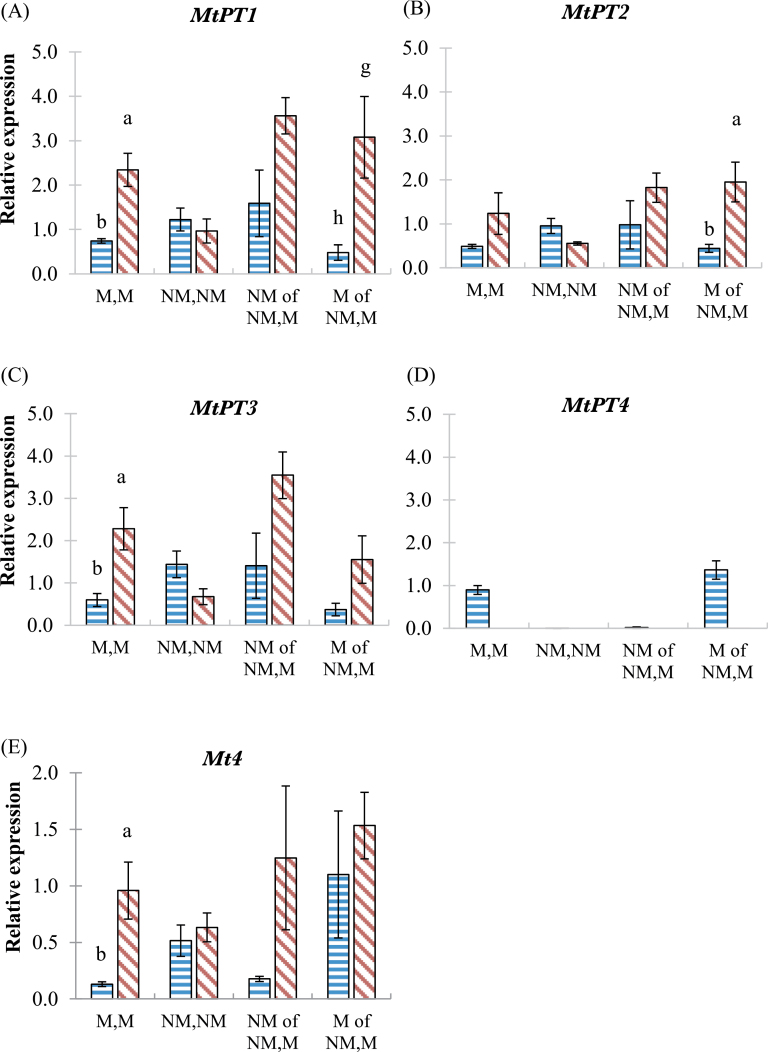
Relative gene expression in roots of wild-type and mtpt4 plants. Expression of direct Pi transporter genes (A–C) MtPT1, MtPT2, and MtPT3 mycorrhiza-induced Pi transporter gene (D) MtPT4, and PSI gene (E) Mt4 in the wild type (horizontal bars) and mtpt4 mutant (diagonal bars) at P20 only. Values are the mean ±standard error, n=3 or 4. Letters (ab, gh) denote a significant difference (at the P<0.05 level, Student’s t-test) between genotypes. See main text for further information. (This figure is available in colour at JXB online.)